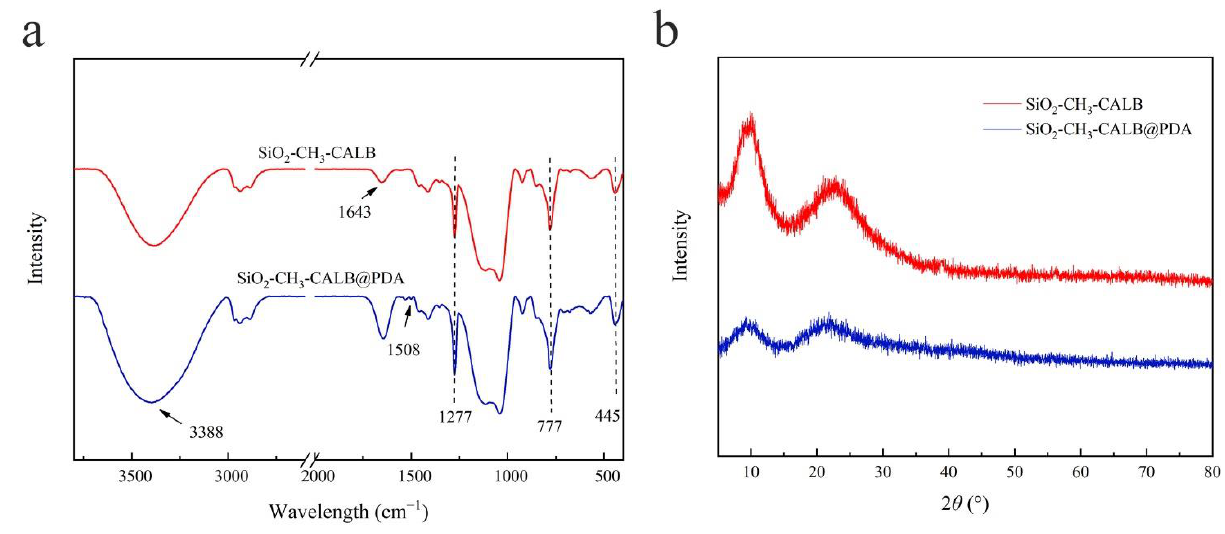
Figure 1. Physical properties of SiO 2 –CH 3 –CALB and SiO 2 –CH 3 –CALB@PDA. ( a ) FTIR spectra and ( b ) XRD 2 θ scans. Microstructural images of SiO 2 –CH 3 –CALB@PDA are shown in Figure 2. Figure 2a,b